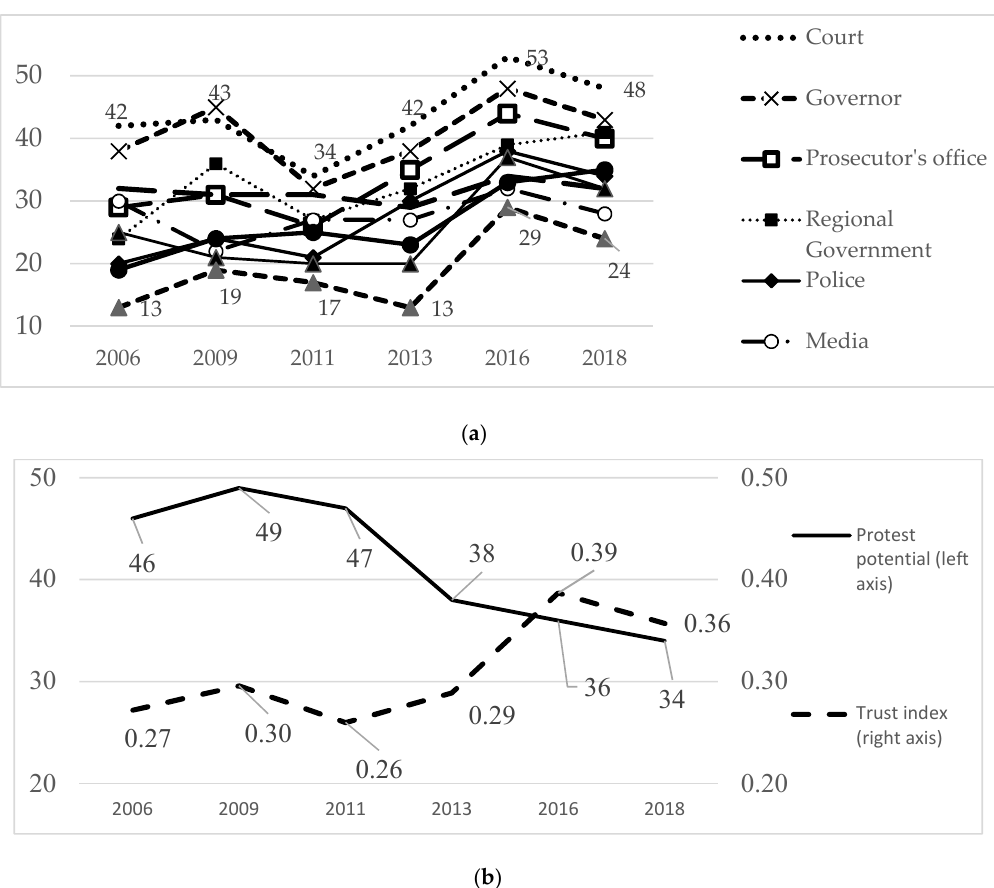
Figure 1. The dynamics of the studied indicators, during the period 2006–2018: ( a ) dynamics of trust in institutions; and ( b ) protest potential, in % of the number of respondents.